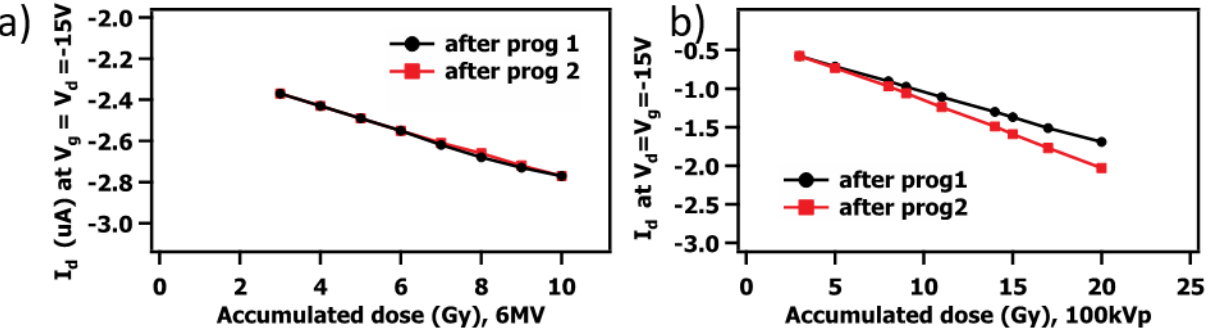
Figure 6. I d vs. dose for a device across two cycles of programming and irradiation at both ( a ) 6 MV and ( b ) 100 kVp. The sensitivity remained constant beyond doses of 3 Gy.